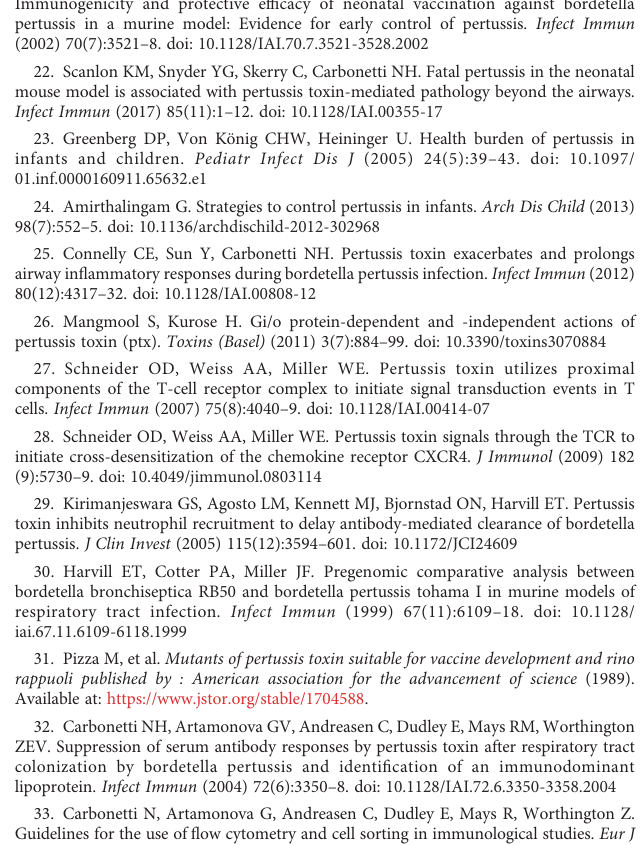
SUPPLEMENTARY FIGURE 7 Effects of pertussis toxin on neonatal (P5-P8) mice are dose-dependent. Survival of mice inoculated at P5 with 10 5 CFU of WT Bp or Bp D ptx in 15 ul over 7 days (A) . Survival of mice inoculated at P5 with 10 6 CFU of WT Bp or Bp D ptx in 15 ul over 4 days (B) . Bacterial recovery from the lungs of mice inoculated with 10 5 CFU of WT Bp or Bp D ptx at 3 dpi (C) (dotted line indicates inoculation dose). Statistical analysis was calculated via student ’ s T test. ***p< 0.0002. SUPPLEMENTARY FIGURE 8 T VM populations in neonatal lungs are not affected by B. pertussis . Total number of T VM in the lungs of pups inoculated with WT Bp , Bp D ptx , or uninfected at 1 (A) and 3 (B) days post inoculation. T VM are identi fi ed as CD3 + NK1.1 - TCRg/d - CD49d lo CD44 hi CXCR3 + Eomes + . Statistical analysis was calculated via One- way ANOVA. (n=4 per strain). Error bars show standard error of the mean. ns p> 0.0332. SUPPLEMENTARY TABLE 1 Comparative group histopathological scores for the lungs of P5 C57BL/6J mice that were infected with WT Bp , Bp D ptx , or PBS and assessed 3 dpi (n=4) (Sev= severity, Dis=